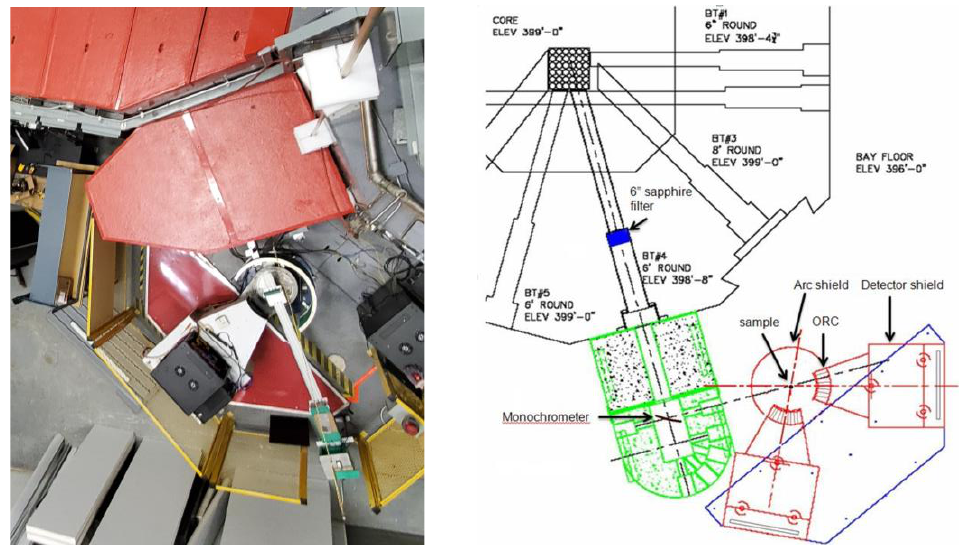
Fig. 6. A view of the NPD facility and its corresponding schematic. Table 1. Characteristics of NPD at the PULSTAR